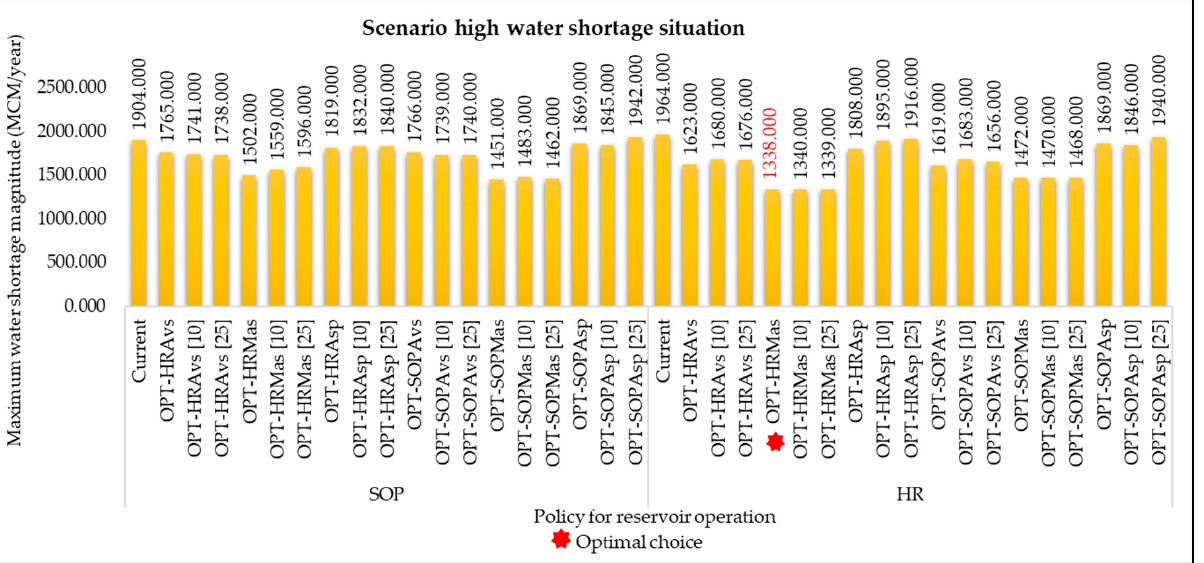
Figure 9. Optimal choice for operating rule curves under serious effect of high water shortage